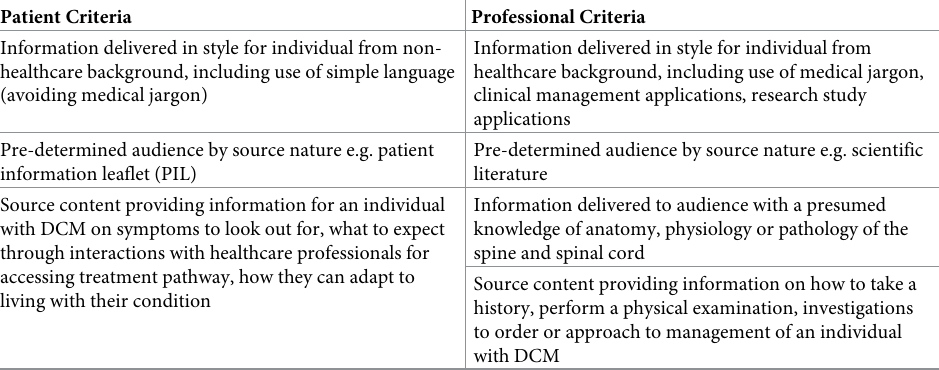
Table 5. Criteria for target audience determination for DCM educational